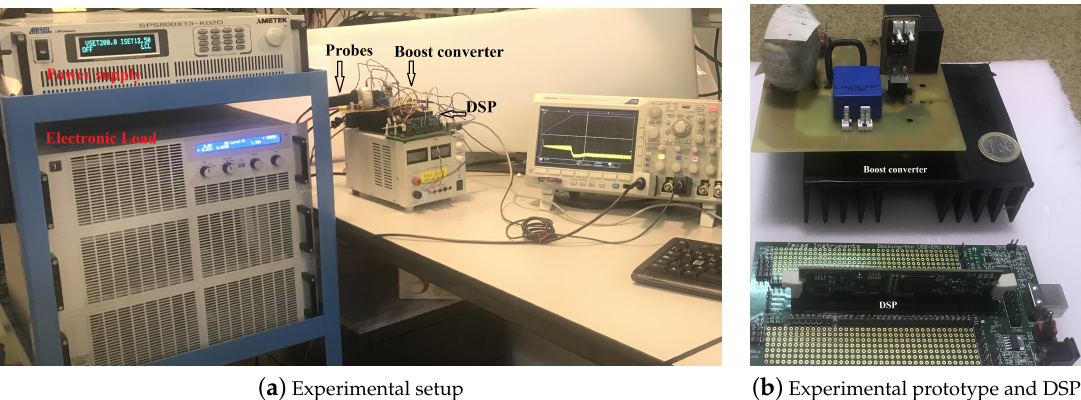
Figure 18. Picture of the benchmark and the implemented experimental